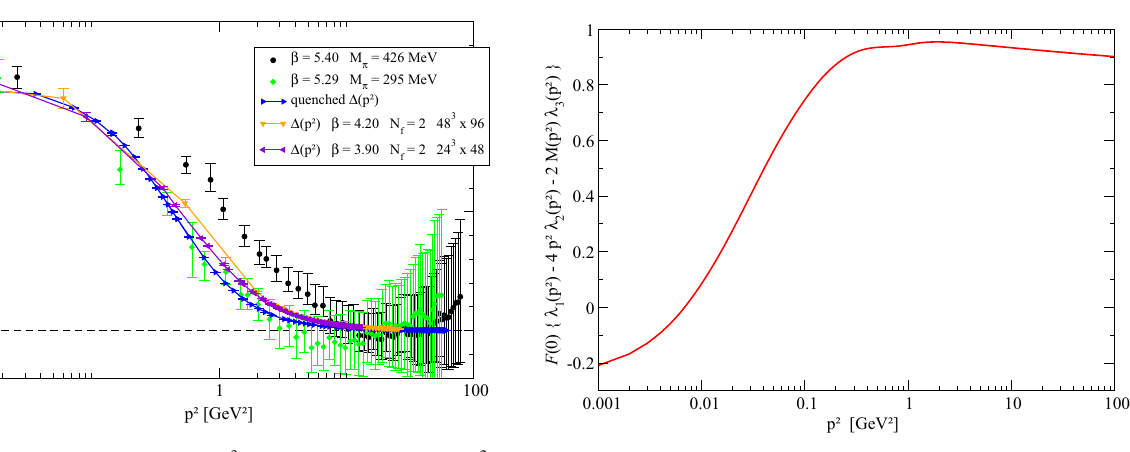
for the β = 5 . 40 simulation and